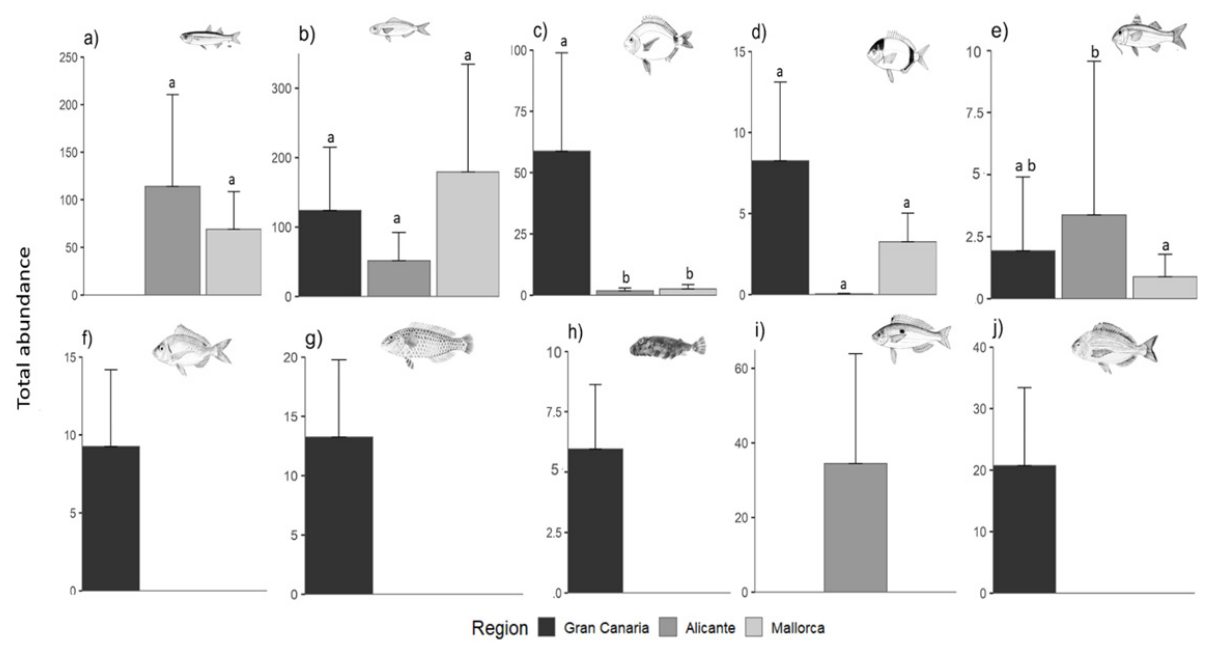
Figure 7. Differences in fish total abundances (Ind m − 2 ) between regions for: ( a ) Atherina sp ., ( b ) Boops boops , ( c ) Diplodus annularis , ( d ) Diplodus vulgaris , ( e ) Mullus surmuletus , ( f ) Pagellus erythrinus , ( g ) Sparisoma cretense , ( h ) Sphoeroides marmoratus , ( i ) Spicara smaris and ( j ) Spondyliosoma cantharus . Different letters above bars denote statistically significant differences between regions. Error bars are + SE of means. n = 9 Data were pooled between meadows within regions and through seasons and years. All fish images were downloaded from the FAO.org webpage, except Sphoeroides marmoratus , whose authorship belongs to Pedro M. Duarte.